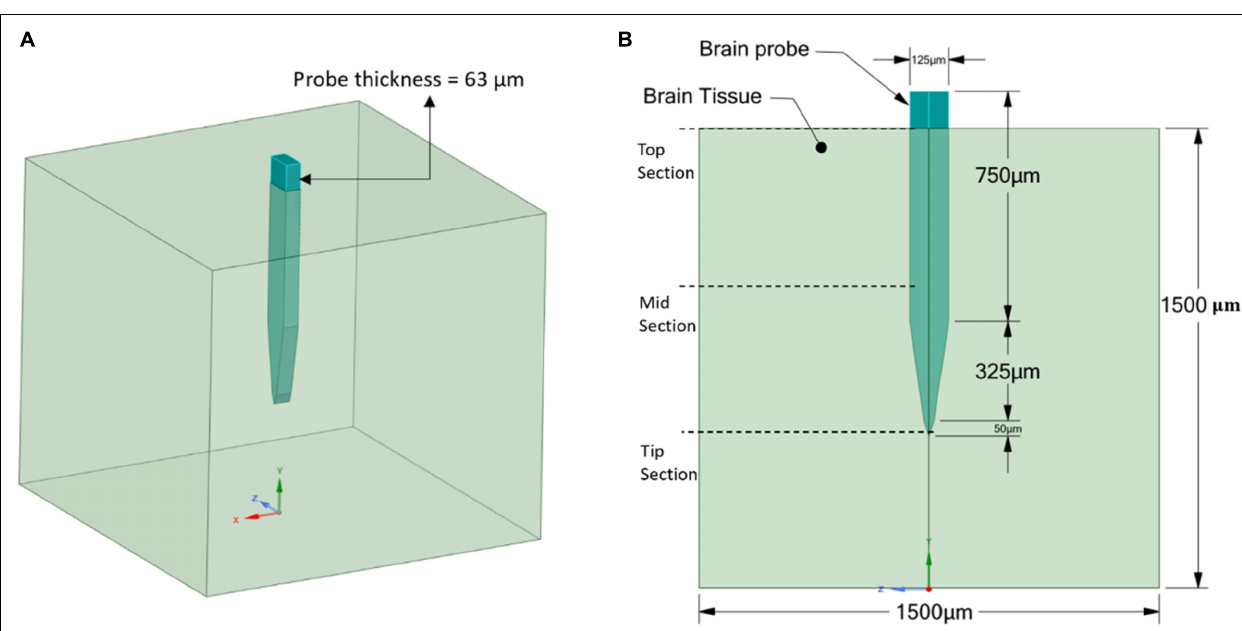
fixed supports at the edges of the bottom of the tissue